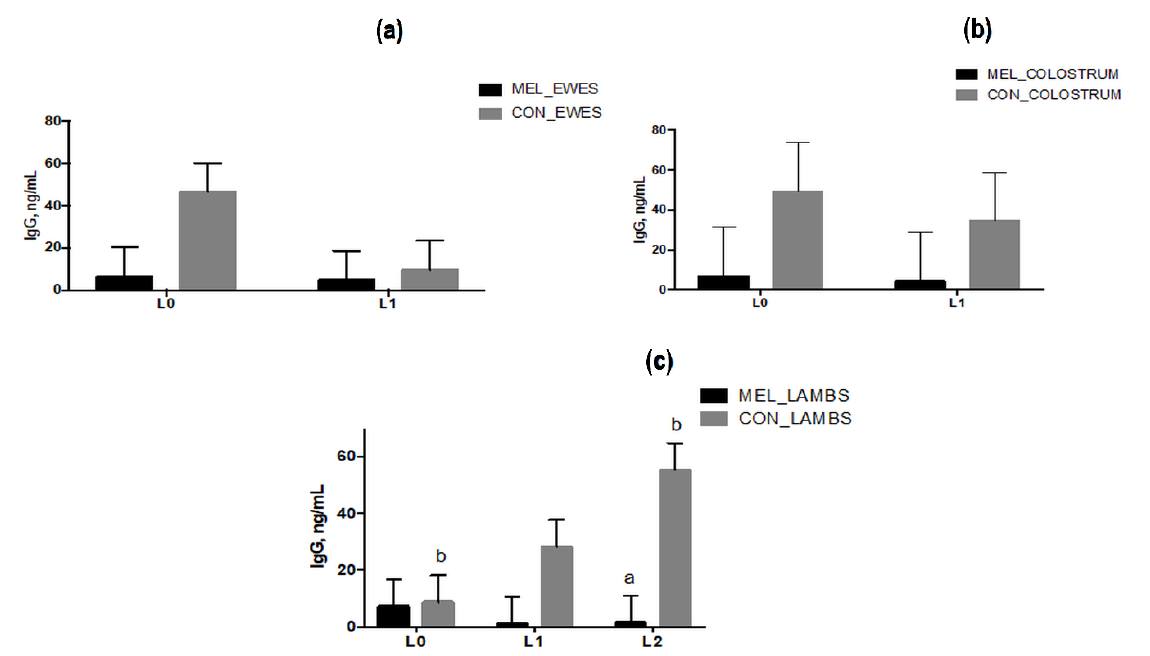
Figure 10. Least squares means ± SEM of levels of plasma IgG ( a ) and of colostrum IgG ( b ) at lambing (L0) and 24 h later (L1) in control ewes (CON) and in melatonin ewes (MEL) and ( c ) of plasma IgG at birth (L0), 24 h (L1) and 48 h later (L2) in lambs born from control ewes (CON) and from melatonin ewes (MEL), p < 0.05, a: among the two groups, b: within time.